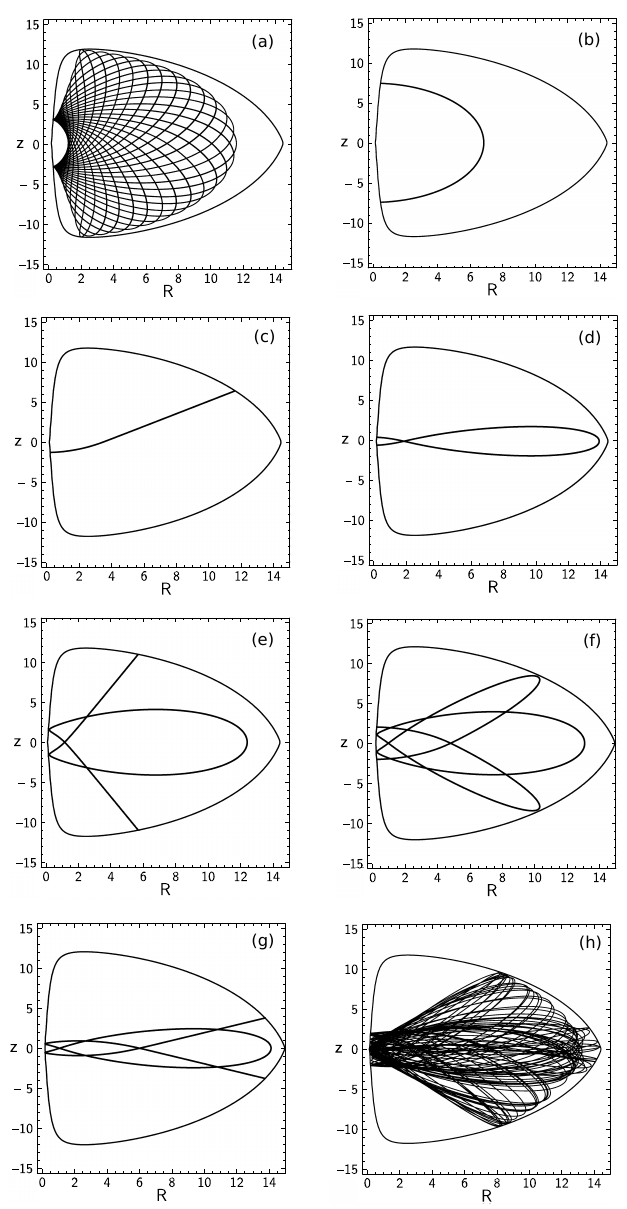
Fig. 3. Orbit collection of the basic types of orbits in our galaxy model: (a) box orbit; (b) 2:1 banana-type orbit; (c) 1:1 linear orbit; (d) 2:3 fish-type orbit; (e) 4:3 boxlet orbit; (f) 6:5 boxlet orbit; (g) 4:5 boxlet orbit, one of our “orbits with other resonance”; (h) chaotic